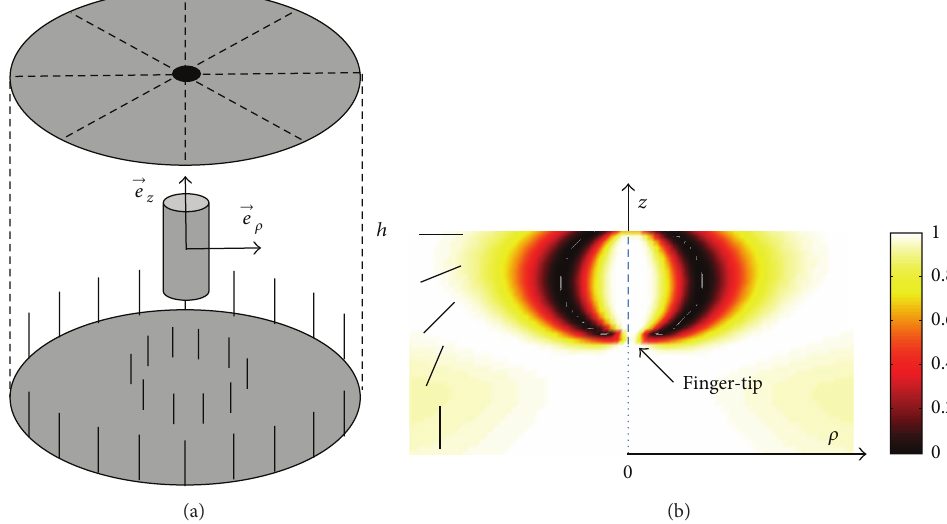
Figure 1: (a) Schematic presentation of the hybrid plan-parallel cell of thickness ℎ hosting a cylindrical NP. The diameter and the height of the NP are set to be equal to 𝜉 𝑏 /3 ∼ 10 nm and ℎ = 10𝜉 𝑏 . (b) Cross section through the boojum is shown where we plot the degree of biaxiality 𝛽 2 . On the left side of the figure we schematically sketch typical nematic director field variation along the 𝑧 -axis away from the axis of symmetry. A biaxial shell joins the isotropic finger-tip and the upper surface. Along the cylindrical axis the system exhibits uniaxial ordering due to topological reasons. With dashed (dotted) line we mark regions exhibiting negative (positive) uniaxiality. In the illustration the anchoring strength at the top plane is finite. The characteristic defect size is comparable to the biaxial correlation length. The colour bar of 1 − 𝛽 2 is shown on the right side of the